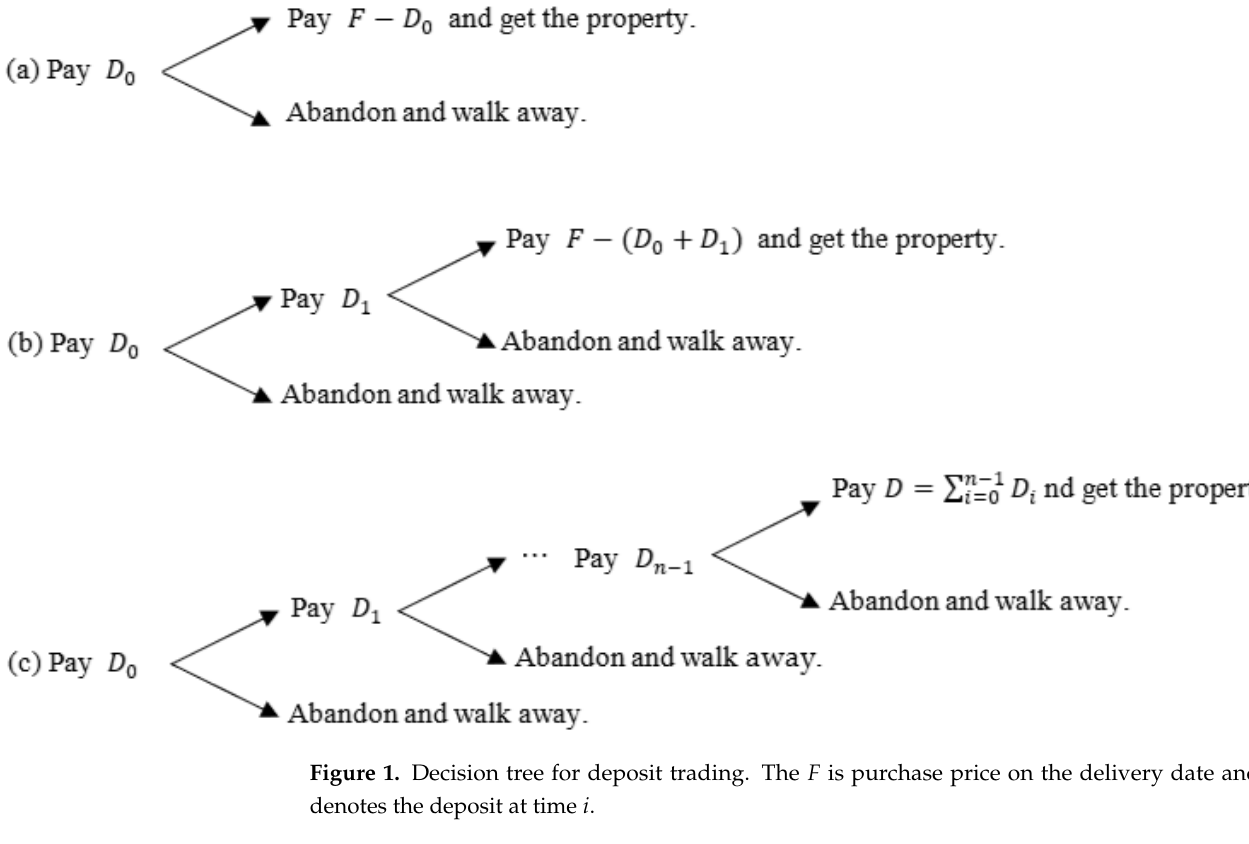
Figure 1. Decision tree for deposit trading. The F is purchase price on the delivery date and D i denotes the deposit at time i